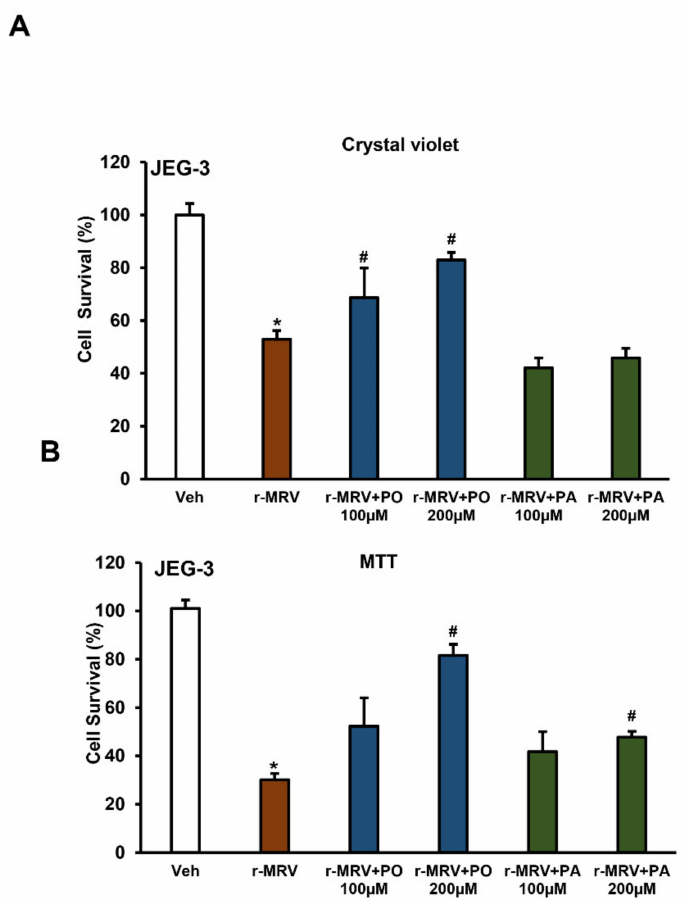
Figure 5. Palmitoleate improves cell viability in Zika virus (ZIKV)-infected cells. ( A ) The percent cell survival using crystal violet assay significantly reduced with 0.1MOI r-MRV when compared to uninfected vehicle cells. The percent cell survival significantly increased with 100 or 200 µ M of palmitoleate treatment but was not seen with 100–200 µ M palmitate treatment, 48 hpi. ( B ) The percent cell survivability using MTT showed significant improvement in cell survivability with 200 µ M palmitoleate treatment in ZIKV-infected cells. Whereas 200 µ M palmitate treatment in ZIKV- infected cells also showed a significant increase in cell survivability. Data represent mean ± SEM, n = 3 for percent cell viability using crystal violet assay and n = 4 for MTT assay. * p < 0.05 compared to uninfected vehicles cells, # p < 0.05 compared to ZIKV-infected